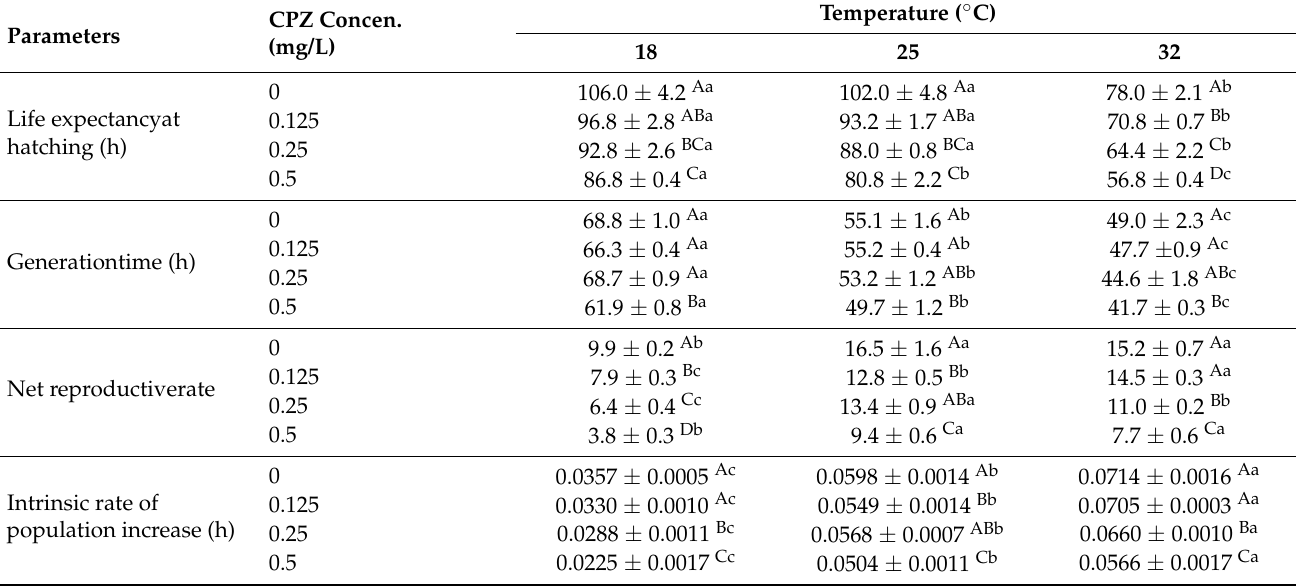
Table 3. Effects of temperatures and chlorpromazine on the life history demographic parameters of B. calyciflorus . Shown are the mean ± standard error based on three